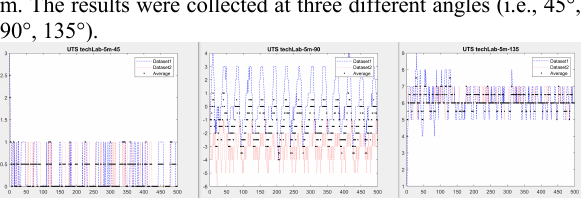
Figure 5 . Experimental site for different testing scenarios, (from left to right, up to bottom) (a) Anechoic chamber; (b) Middle of tunnel in the underground mine; (c) Edge of tunnel in the underground mine; (d) Open site; (e) Office area.